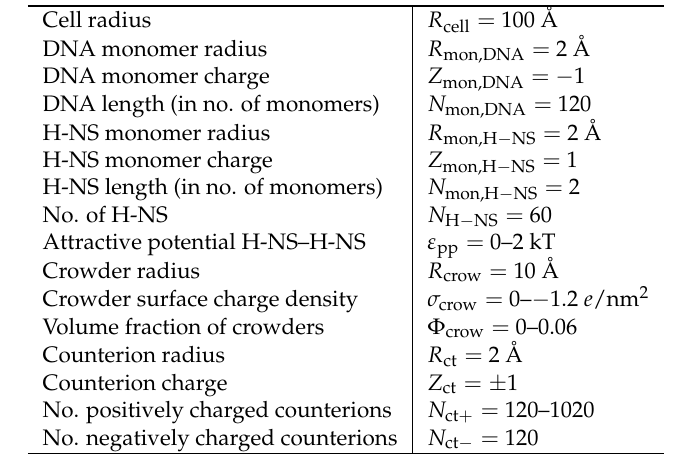
Table 1. General data of the